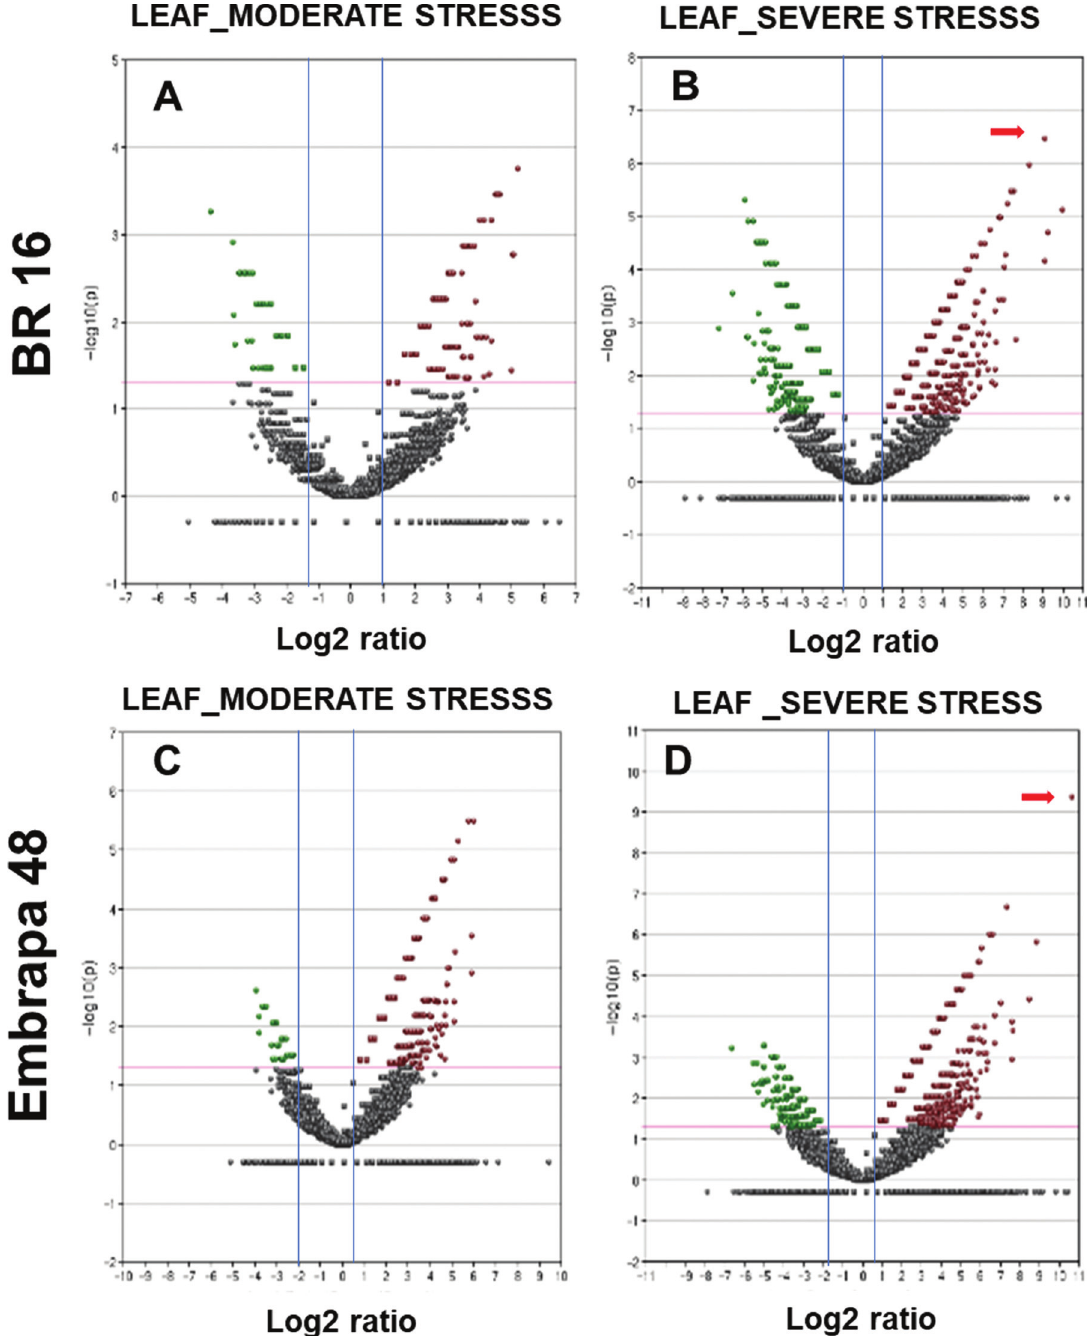
Figure 2 - Volcano plots. Expression data (fold-change) were plotted using log2 scale (x-axis) and -log 10 transformation of the p -value (y-axis). Datasets were filtered to remove genes with low expression levels (blue line on the x-axis (cid:5) 1 and -1 and red lines on the y-axis); the red line is the threshold applied to delimit a significance cut off ( p < 0.01). The red points were used to represent up-regulated genes and green points down-regulated genes. The red ar- rows indicate the highest expression of the same genes for (A) leaf from BR 16 in moderate stress library; (B) leaf from BR 16 in stress severe stress li- brary; (C) leaf from Embrapa 48 in moderate stress library; (D) leaf from Embrapa 48 in severe stress